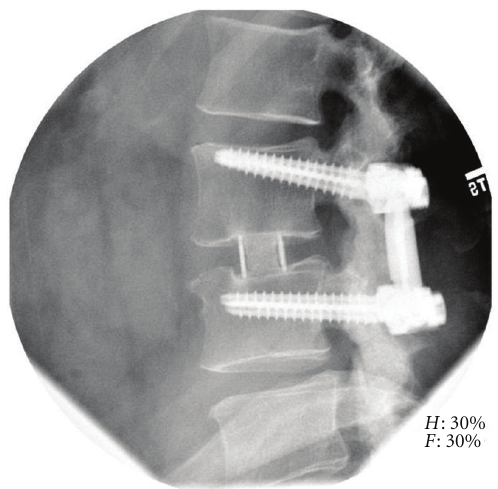
Figure 5: Lateral radiograph of L3-4 extreme lateral interbody fusion with Osteocel Plus at 12-month